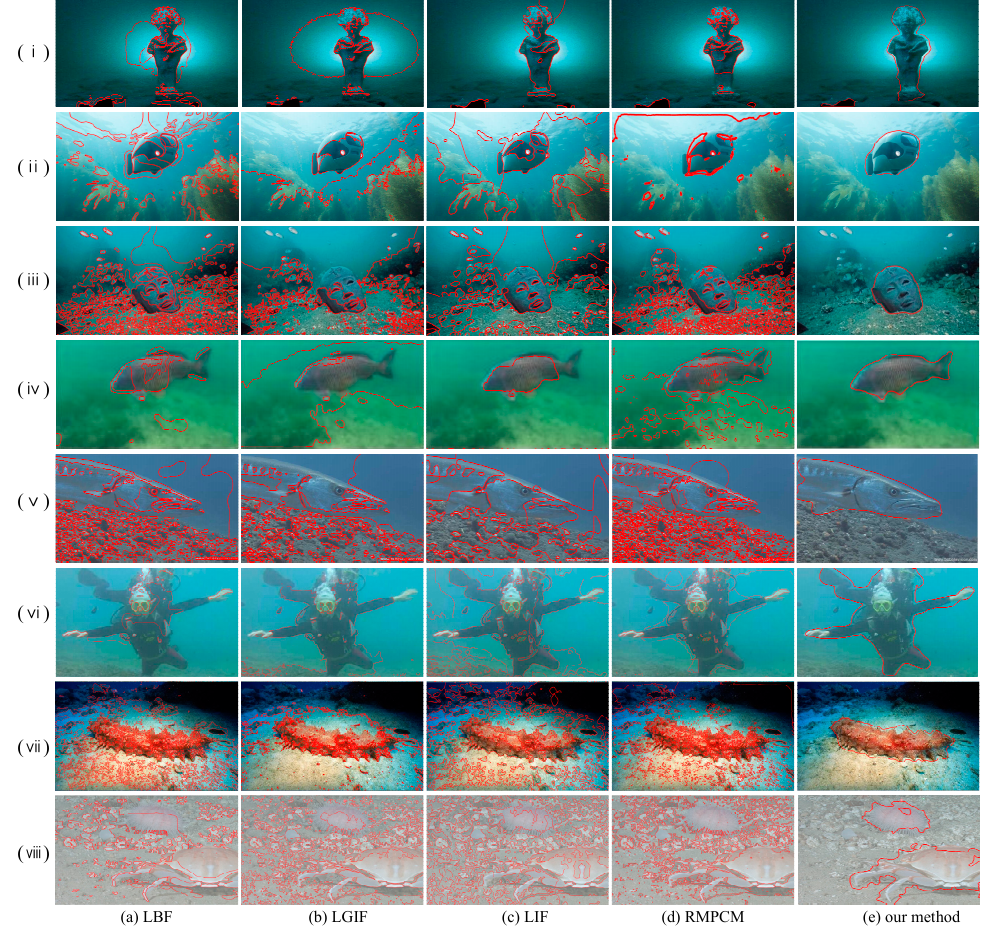
Figure 5. Comparison of our method with LBF, LGIF, LIF, RMPCM. ( a ) Results of the LBF model. ( b ) Results of the LGIF model. ( c ) Results of the LIF model. ( d ) Results of the RMPCM model. ( e ) Results of our